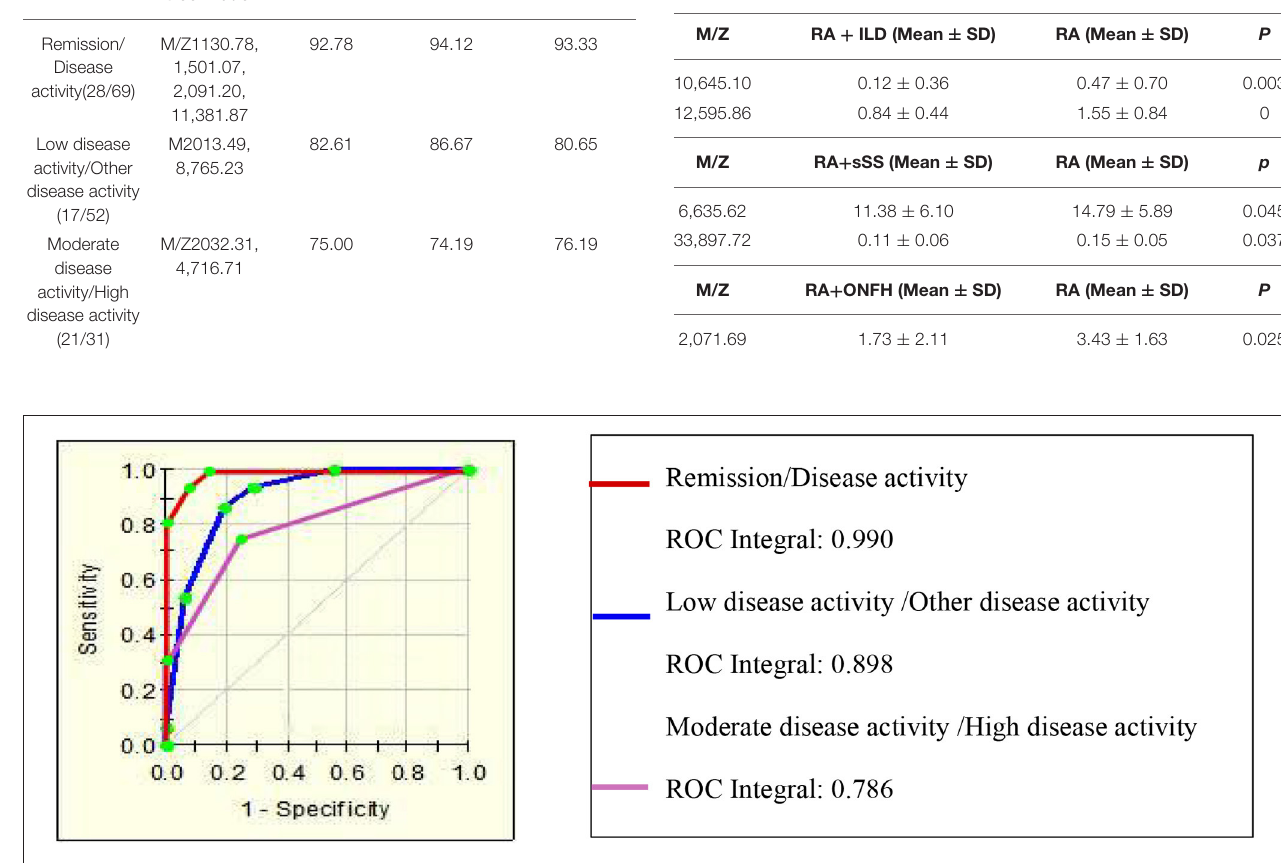
FIGURE 4 | The ROC of the diagnostic models for assessing the activity of disease in RA patients.